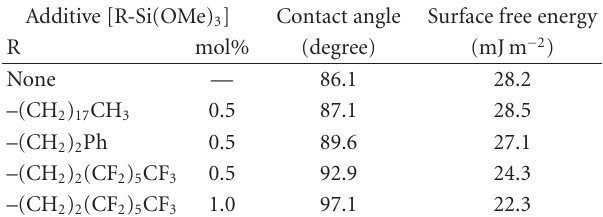
Table 4: Surface properties of co-PMSQ thin